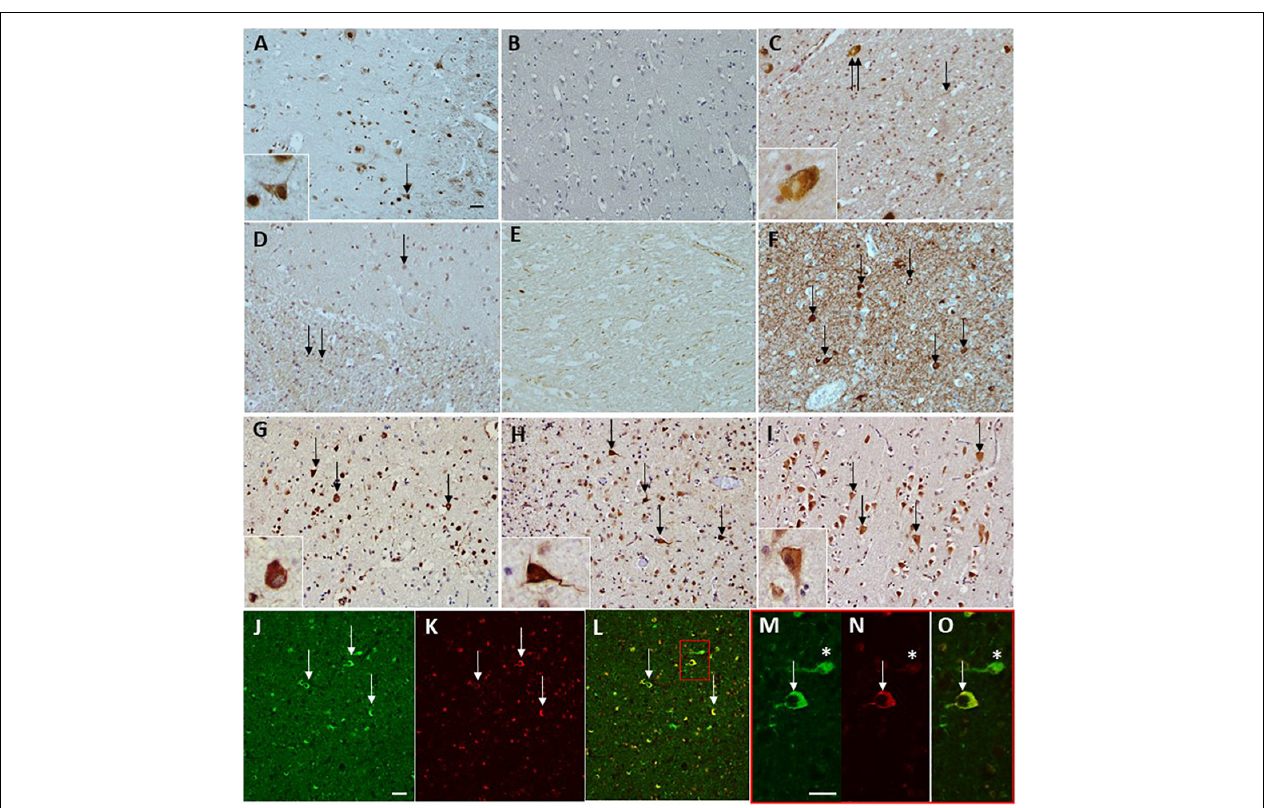
FIGURE 1 | Immunohistochemical staining of anti-CoA and tau antibodies in neurodegenerative diseases. CoA deposition is found in a case with NBIA (A) used as a positive control for the immunohistochemical preparations. No CoA immunoreactivity was observed in a neurologically normal control without the presence of tau pathology (B) . CoA immunoreactivity was observed in PD, in the occasional Lewy body ( C , double arrow and insert), as well as the occasional Lewy neurite ( C , arrow). No CoA immunoreactivity was observed in either MSA white matter (WM) or gray matter (GM). Both PSP and CBS were negative for CoA in the frontal and temporal cortices. However, axonal CoA staining was observed in the basal ganglia in CBD (E) . Tau immunohistochemistry demonstrating the level of tau pathology in the form of neurofibrillary tangles ( F , arrows) surrounded by neuropil threads in an AD case. CoA immunohistochemistry in AD also shows positivity in the neurofibrillary tangles in the frontal cortex ( G , arrows and insert), temporal cortex ( H , arrows and insert), and CA1 subregion of the hippocampus ( I , arrows and insert). Double immunohistochemical staining with CoA (red; K,N ) and tau (green; J,M ) shows co-localization of the two proteins (arrows, L ) and at higher magnification (O) , but also reveals neurofibrillary tangles that are negative for CoA (asterisks, M–O ). Bar in a represents 50 µ m in panels (A–L) , inserts 20 µ m. Bar in panels (J,M) represents 50 µ m. PD, Parkinson’s disease; MSA, multiple system atrophy; AD, Alzheimer’s disease; PSP, progressive supranucelar palsy; CBD, corticobasal